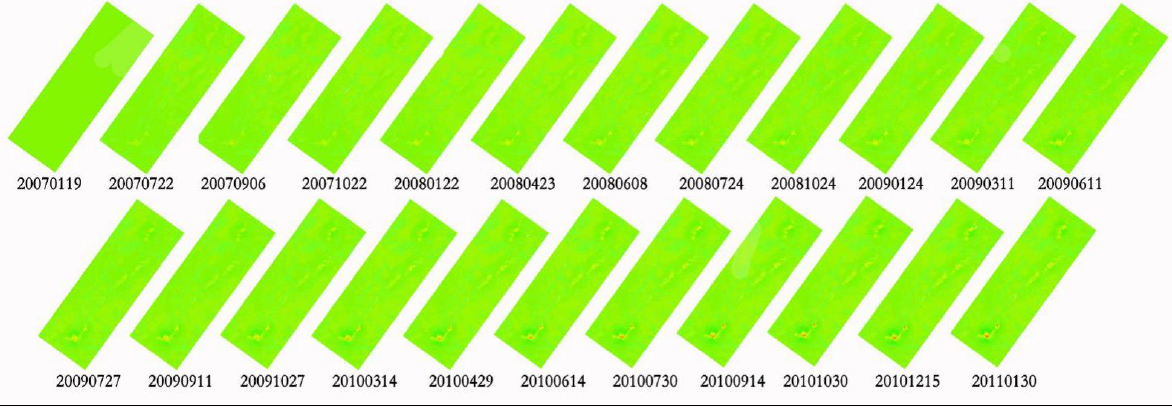
Figure 5. Deformation amount time-series change from 2007 to 2011